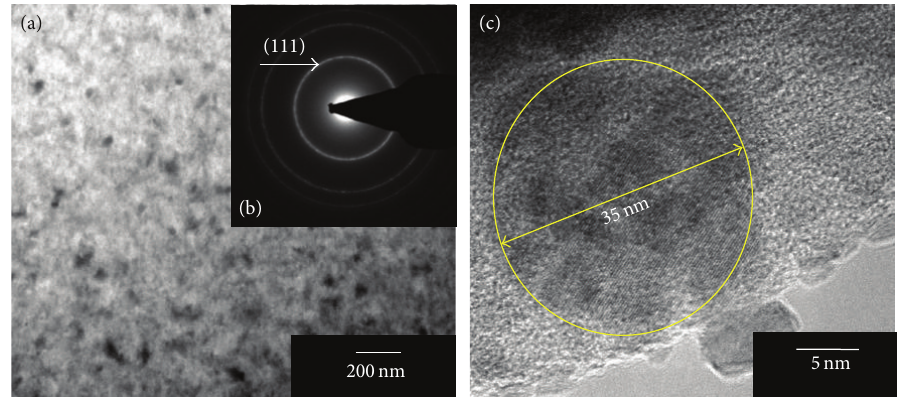
Figure5:(a),(b),and(c)BrightfieldTEMimage,correspondingSAEDpattern,andhighresolutionTEMimagesfordiamondfilmsdeposited at 35 Torr of working pressure.